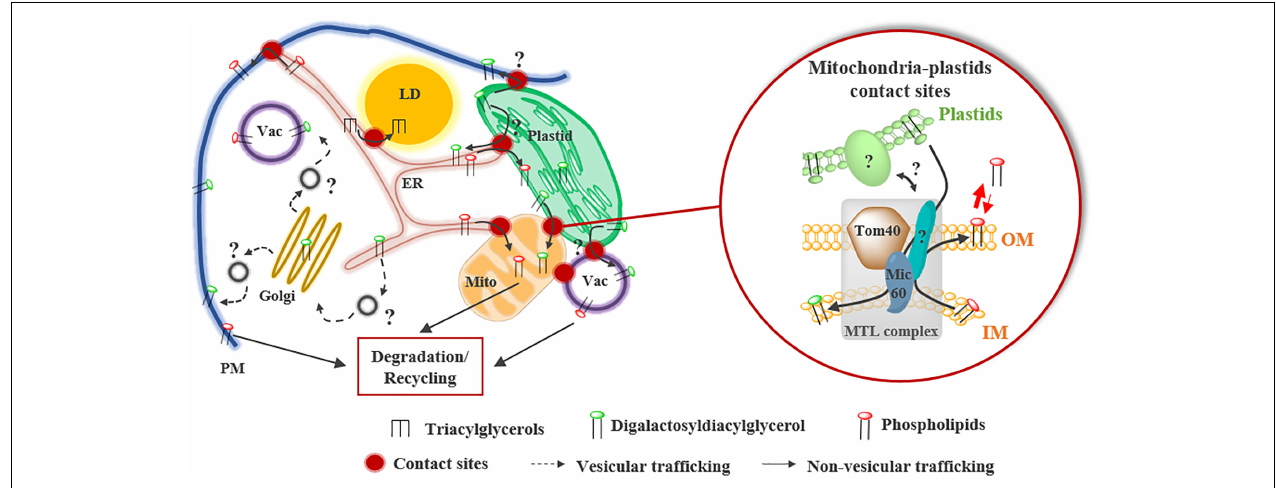
FIGURE 4 | Lipid remodeling during Pi starvation in higher plants. During Pi starvation, phospholipids are partially degraded and replaced by the galactoglycerolipid DGDG synthesized in plastids. DGDG transport from plastids to mitochondria (Mito) occurs at contact sites and is partly mediated by the mitochondrial transmembrane lipoprotein (MTL) complex. Inside this complex, Mic60, located in the inner membrane (IM) of mitochondria, plays a key role in the import of DGDG from plastids and in the export of phosphatidylethanolamine from mitochondria. Mic60 interacts with Tom40 located in the outer membrane (OM) of mitochondria at OM-IM contact sites. Whether the transfer of DGDG to plasma membrane (PM) and vacuole (Vac) occurs at contact sites or via the vesicular transfer pathway is still